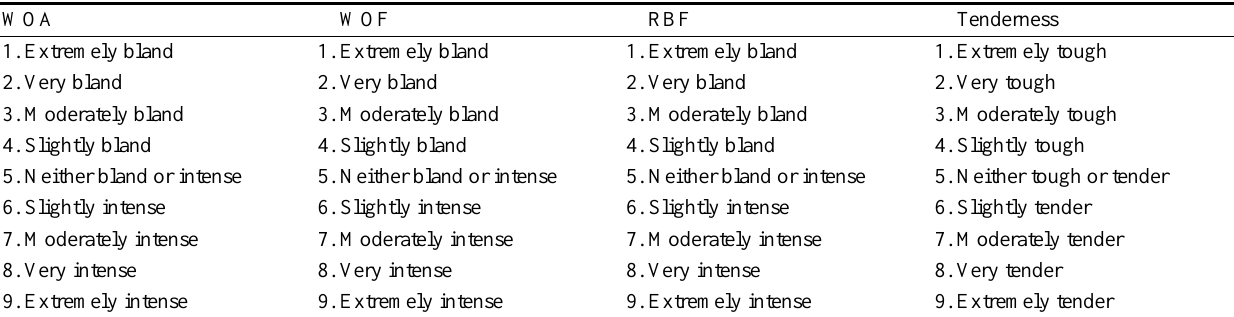
Table 1. A 9-point category scores for descriptive attributes of precooked roast beef WOA WOF RBF Tenderness 1. Extremely bland